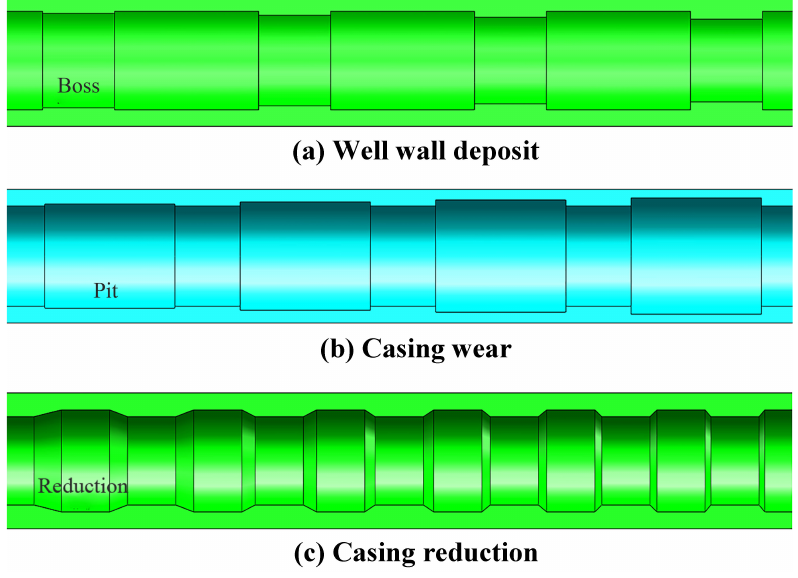
Figure 6. Simulated casing with single obstacle.